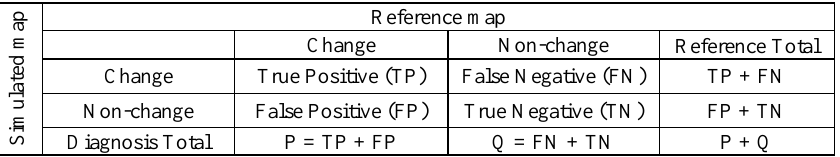
Table 2. Comparing simulated map and reference man using contingency tables